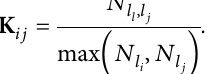
Figure 1: The results of the division of English information cloud drop based on PCA.